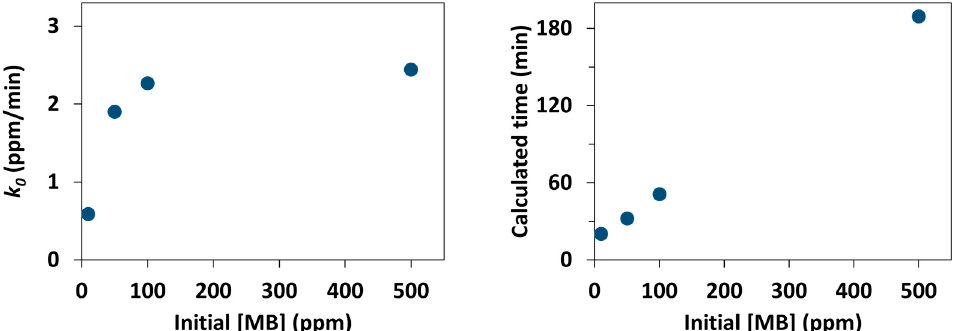
Figure 10. Rate constant ( left ) and calculated time ( right ) of MB degradation using different initial MB concentrations.